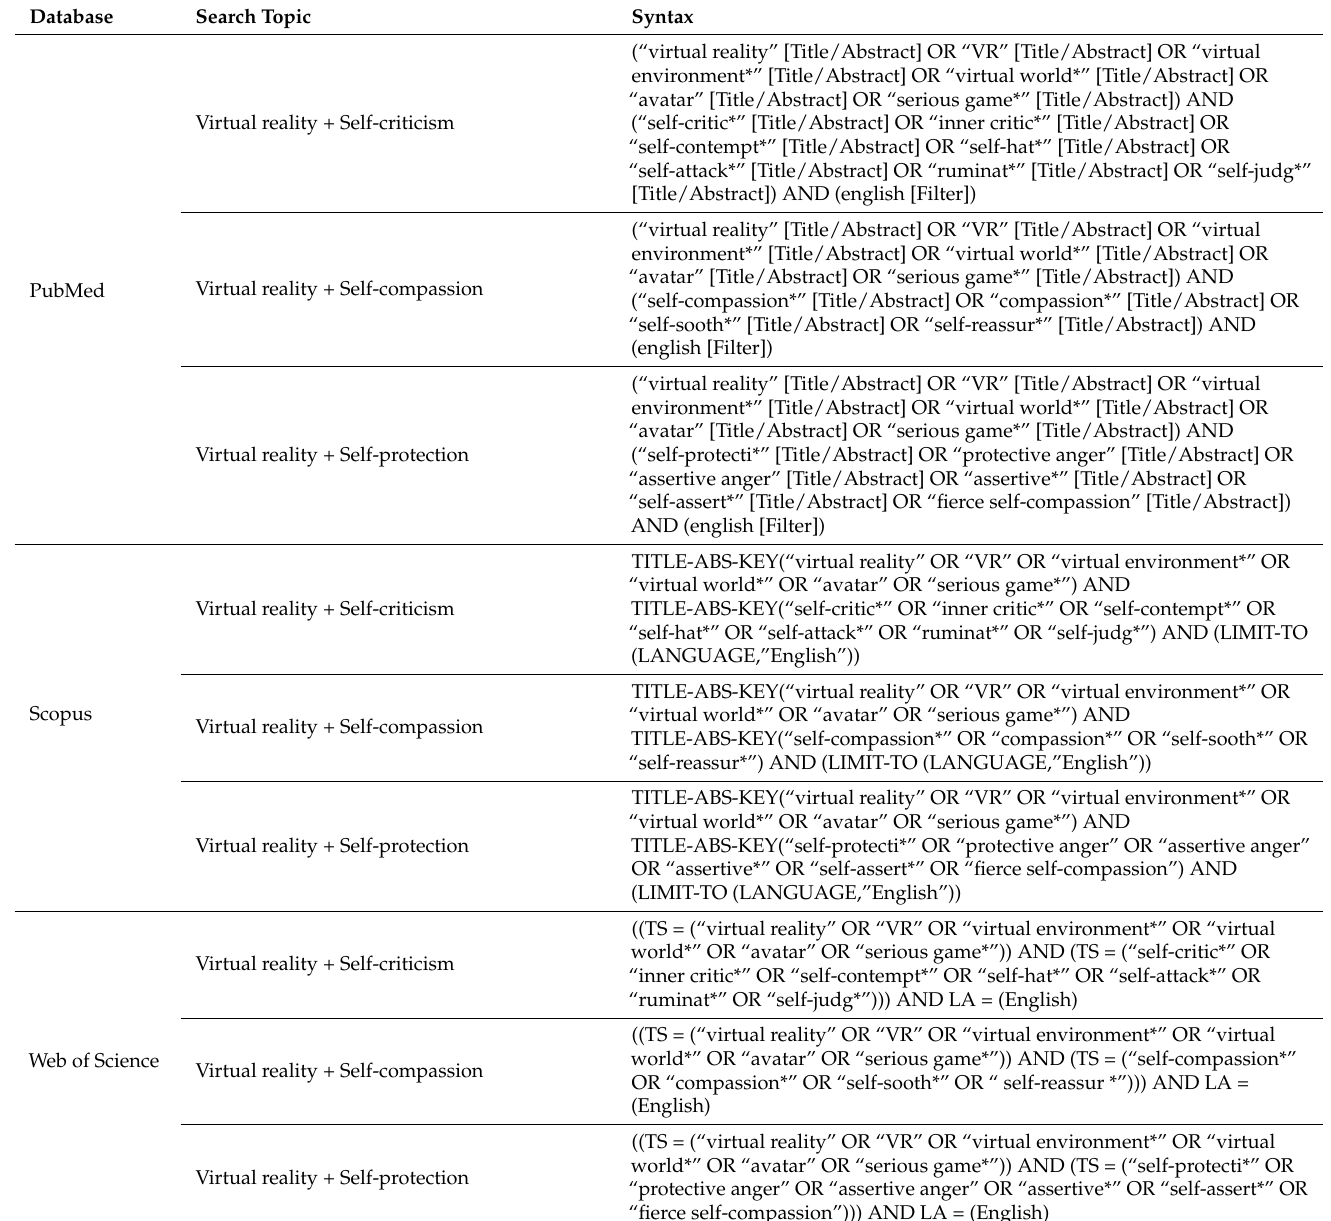
Table A1. Search syntax for selected